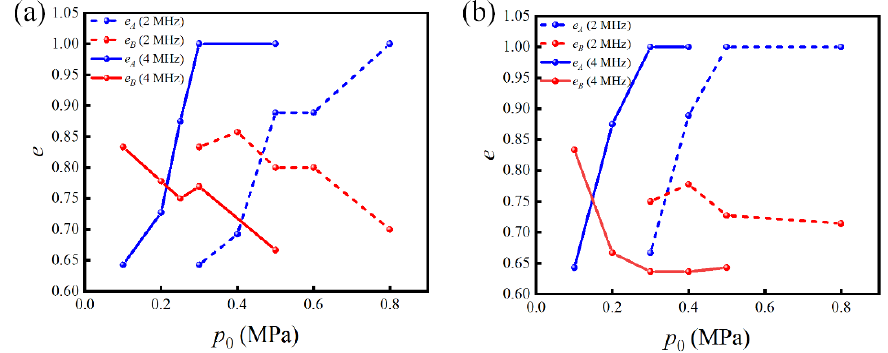
Figure 8. Comparison of the separation efficiency between PCPs with resonant frequencies of 2 and 4 MHz under the conditions of u 0 = 5 mm/s and different channel heights of ( a ) 100 and ( b ) 200 µ